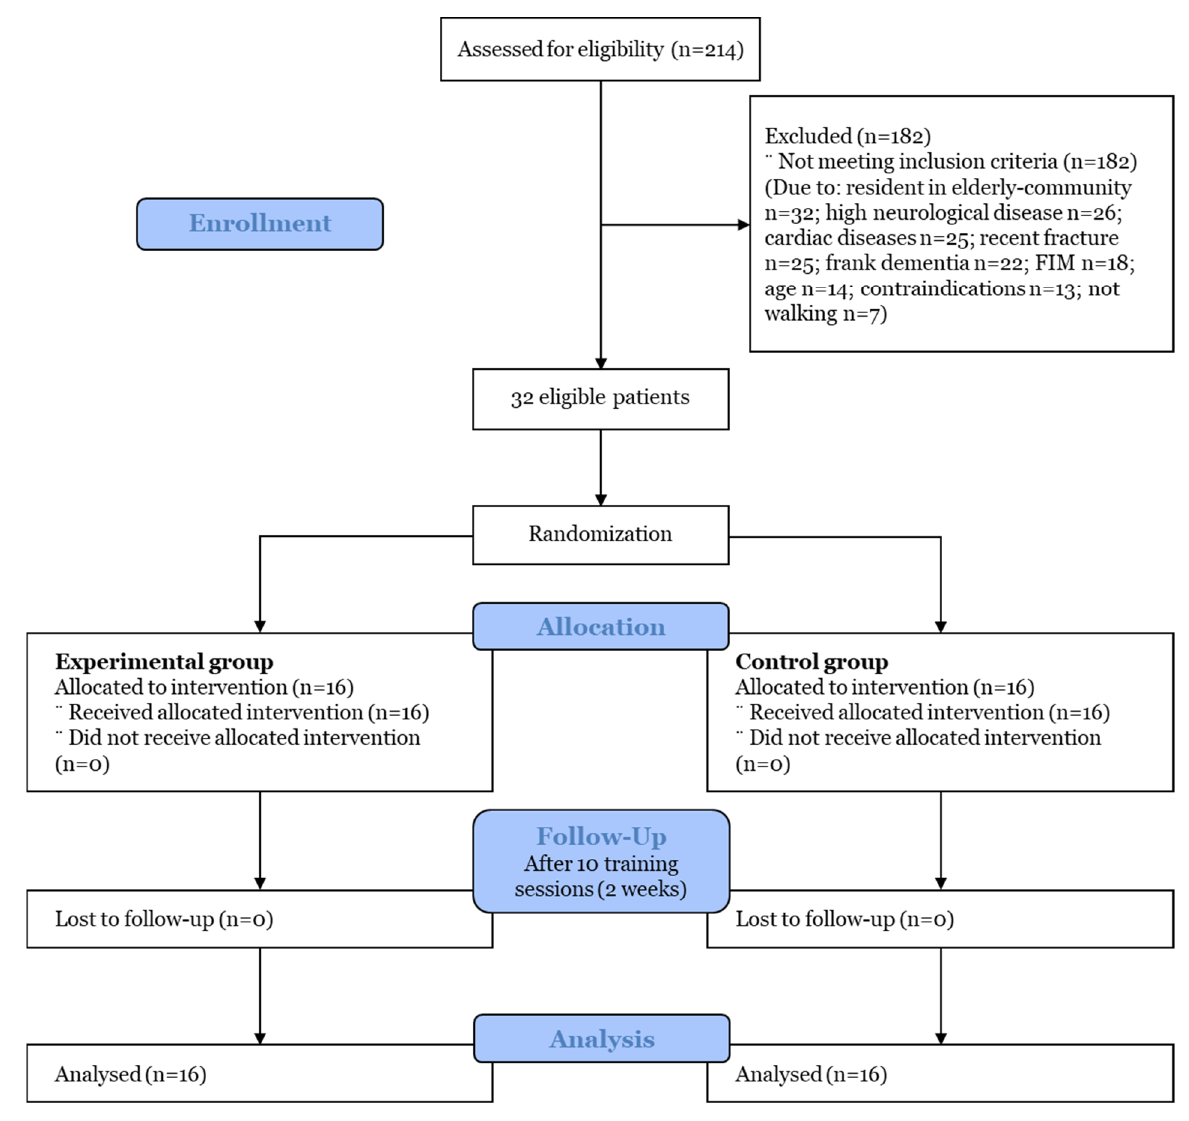
Figure 1. CONSORT flow diagram. Table 1. Baseline characteristics of participants (n =